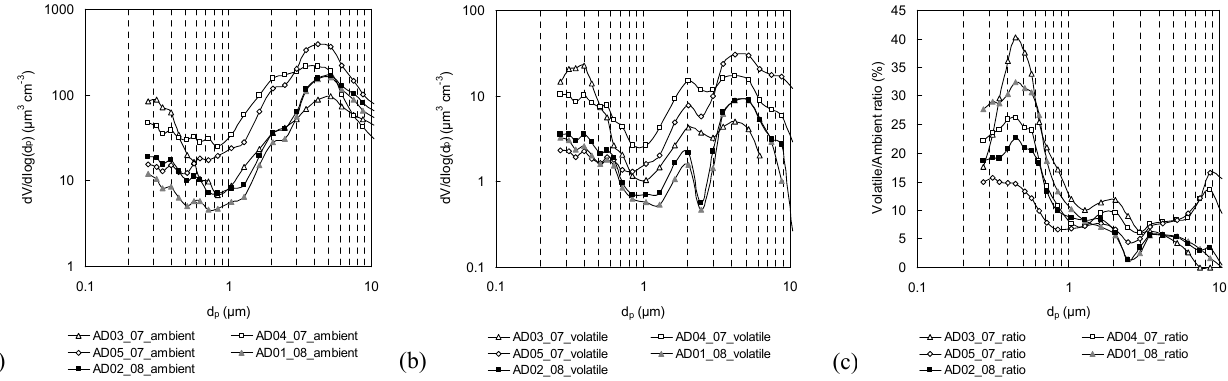
Fig. 17. Volume size distribution of (a) ambient, (b) volatile aerosol, and (c) volatile fraction to ambient aerosol during the Asian dust